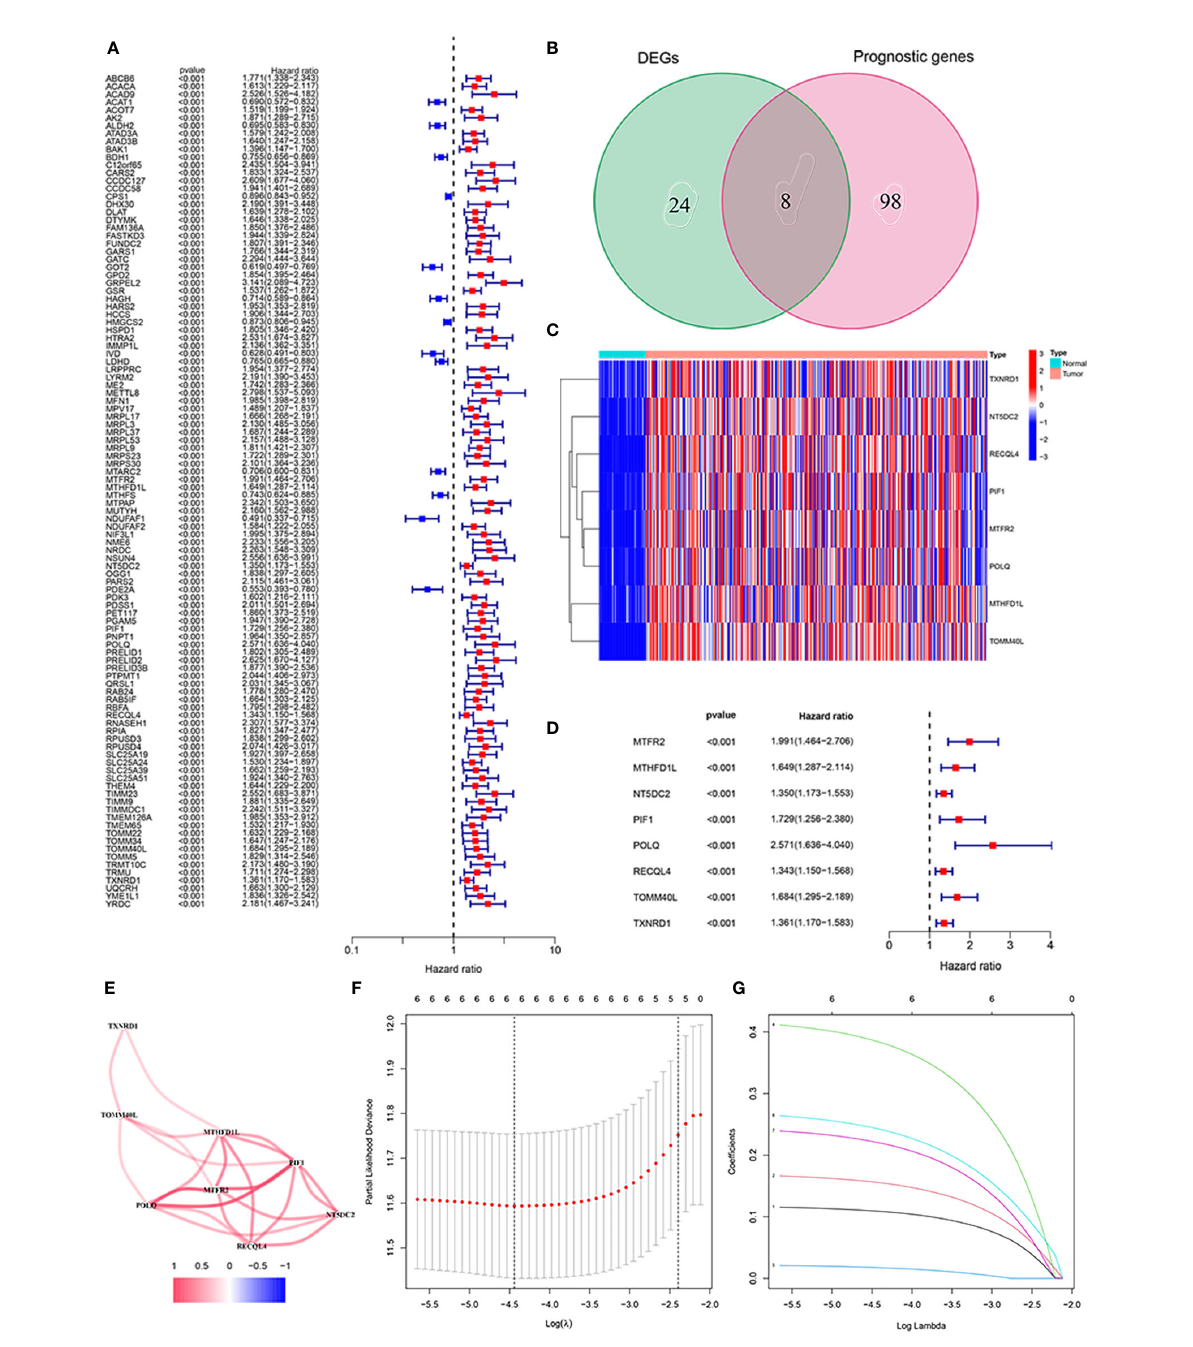
FIGURE 1 Identi fi cation of the mitochondria-related prognostic signature in the TCGA cohort. (A) The association between prognostic gene expression and OS by forest plot. (B) Venn diagram to classify the DEG between HCC and adjacent normal tissues. (C) Heat map of the expression of eight overlapping genes. (D) Univariate Cox regression analysis of eight overlapping genes related to OS. (E) Correlation network of prognostic genes. (F) LASSO regression with tenfold cross-validation identi fi ed ten prognostic genes using the minimum l . (G) LASSO coef fi cient pro fi les of six prognostic genes in